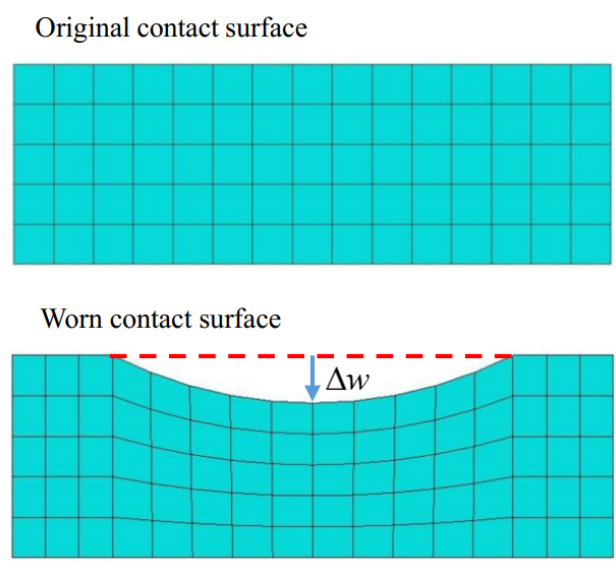
Figure 2. Schematic of wear and contact geometry variation.